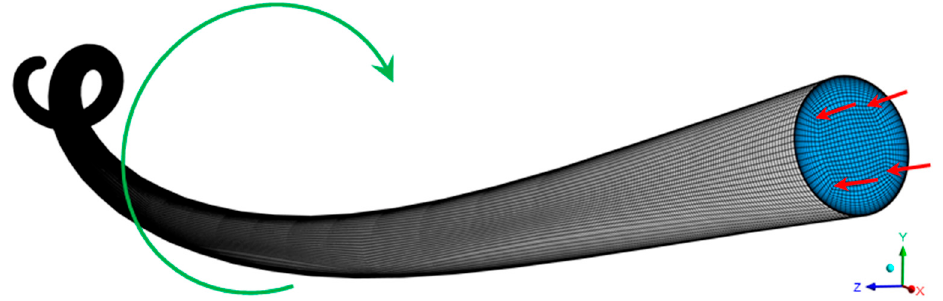
Figure 2. Perspective view of the numerical domain and computational mesh of the twisted circular channel; the red arrows indicate the flow direction at the microchannel inlet while the green arrow indicates the rotation direction of the drill bit.